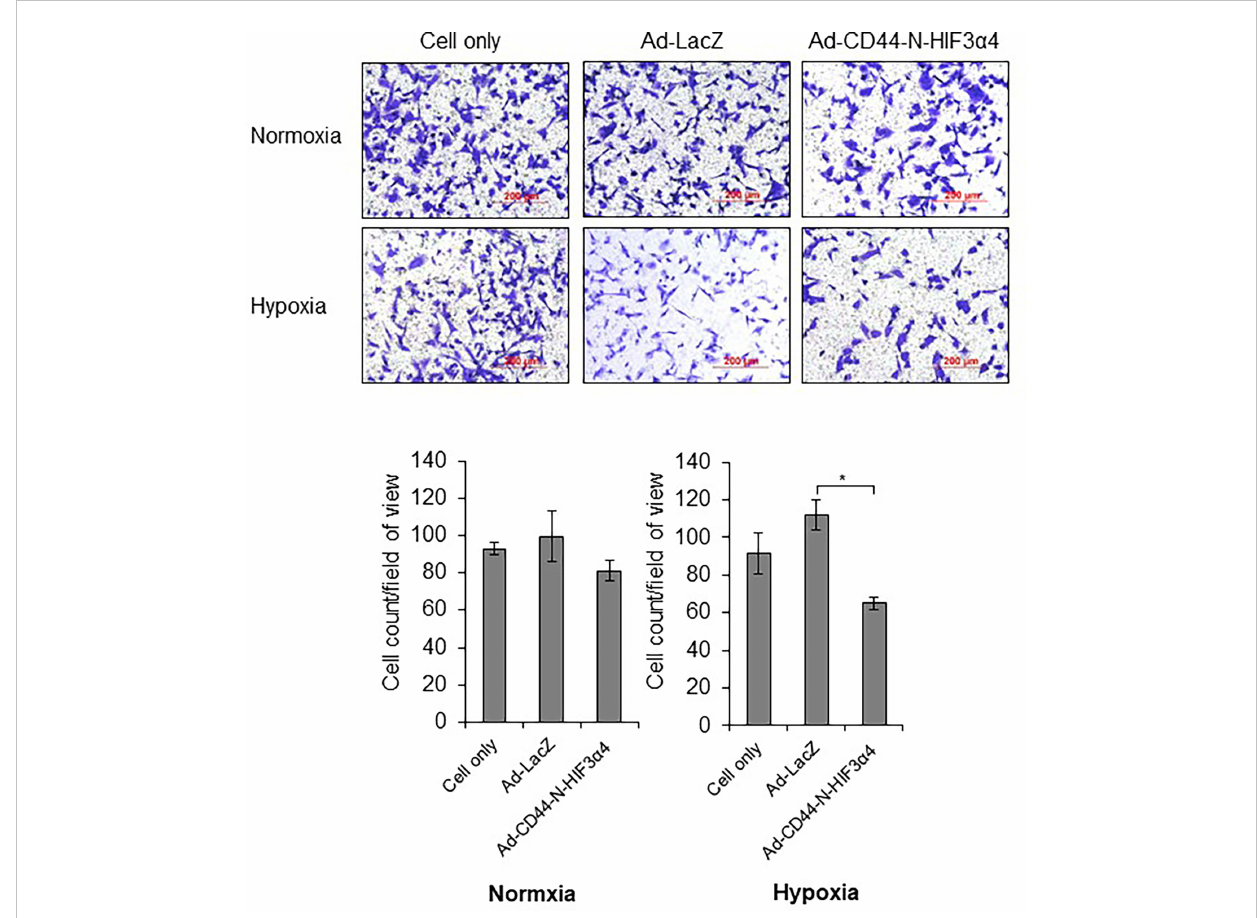
FIGURE 5 Ad-CD44-N-HIF3 a 4 inhibited migration in MDA-MB-231 in hypoxia condition, Ad-CD44-N-HIF3 a 4 signi fi cantly inhibited the cell migration of MDA- MB-231 cells in hypoxia condition but not in normoxia condition. Magni fi cation: ×100 (n=3, average ± SE bars, *p<